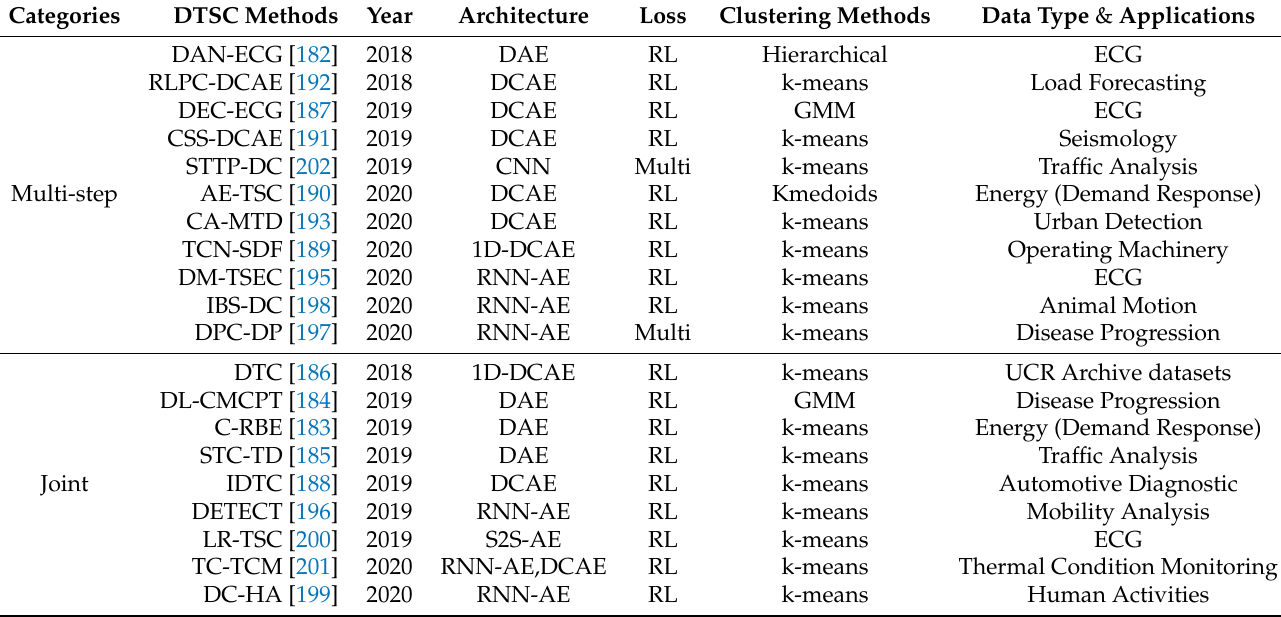
Table 3. Deep Time-series Clustering Methods. RL indicates reconstruction